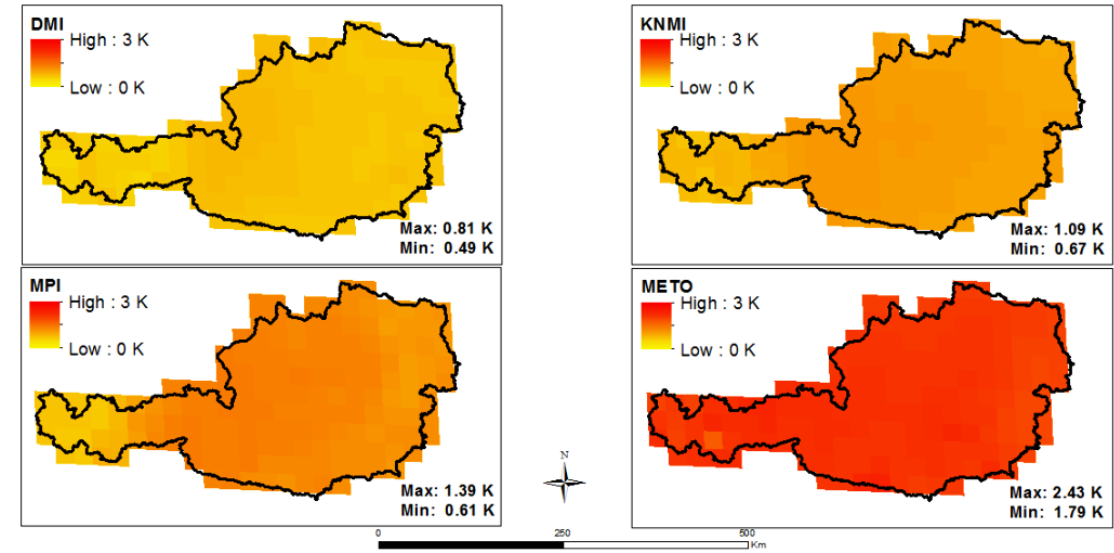
Figure 4. Absolute difference of mean air temperature in the winter season (DJF) between the periods 1961–1990 and 2011–2040.